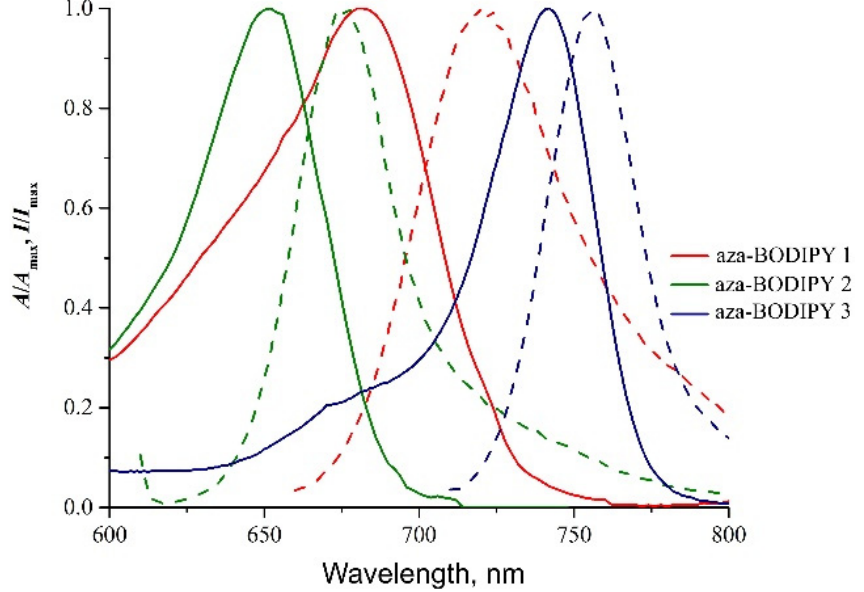
Figure 2. Normalized absorption (solid lines) and normalized fluorescence (dotted lines) spectra of the investigated aza-BODIPYs in DCM.